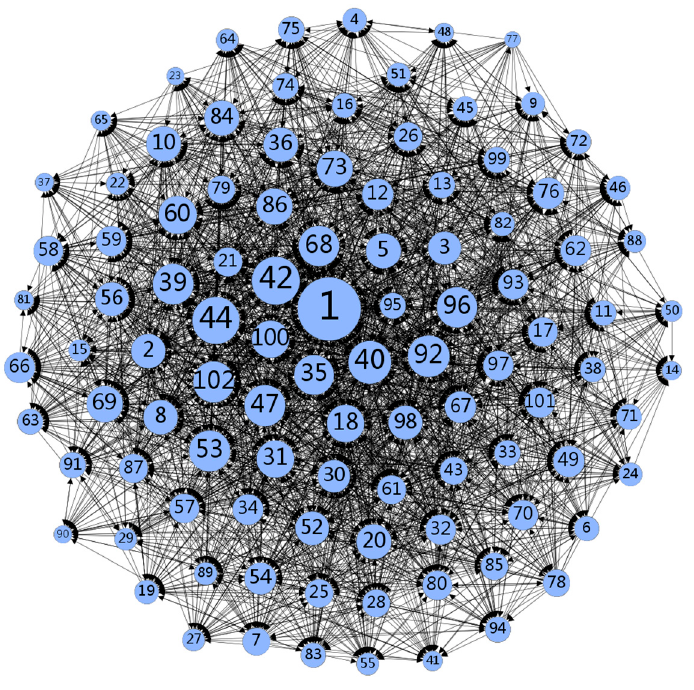
Figure 1. Doctor information interaction network diagram.